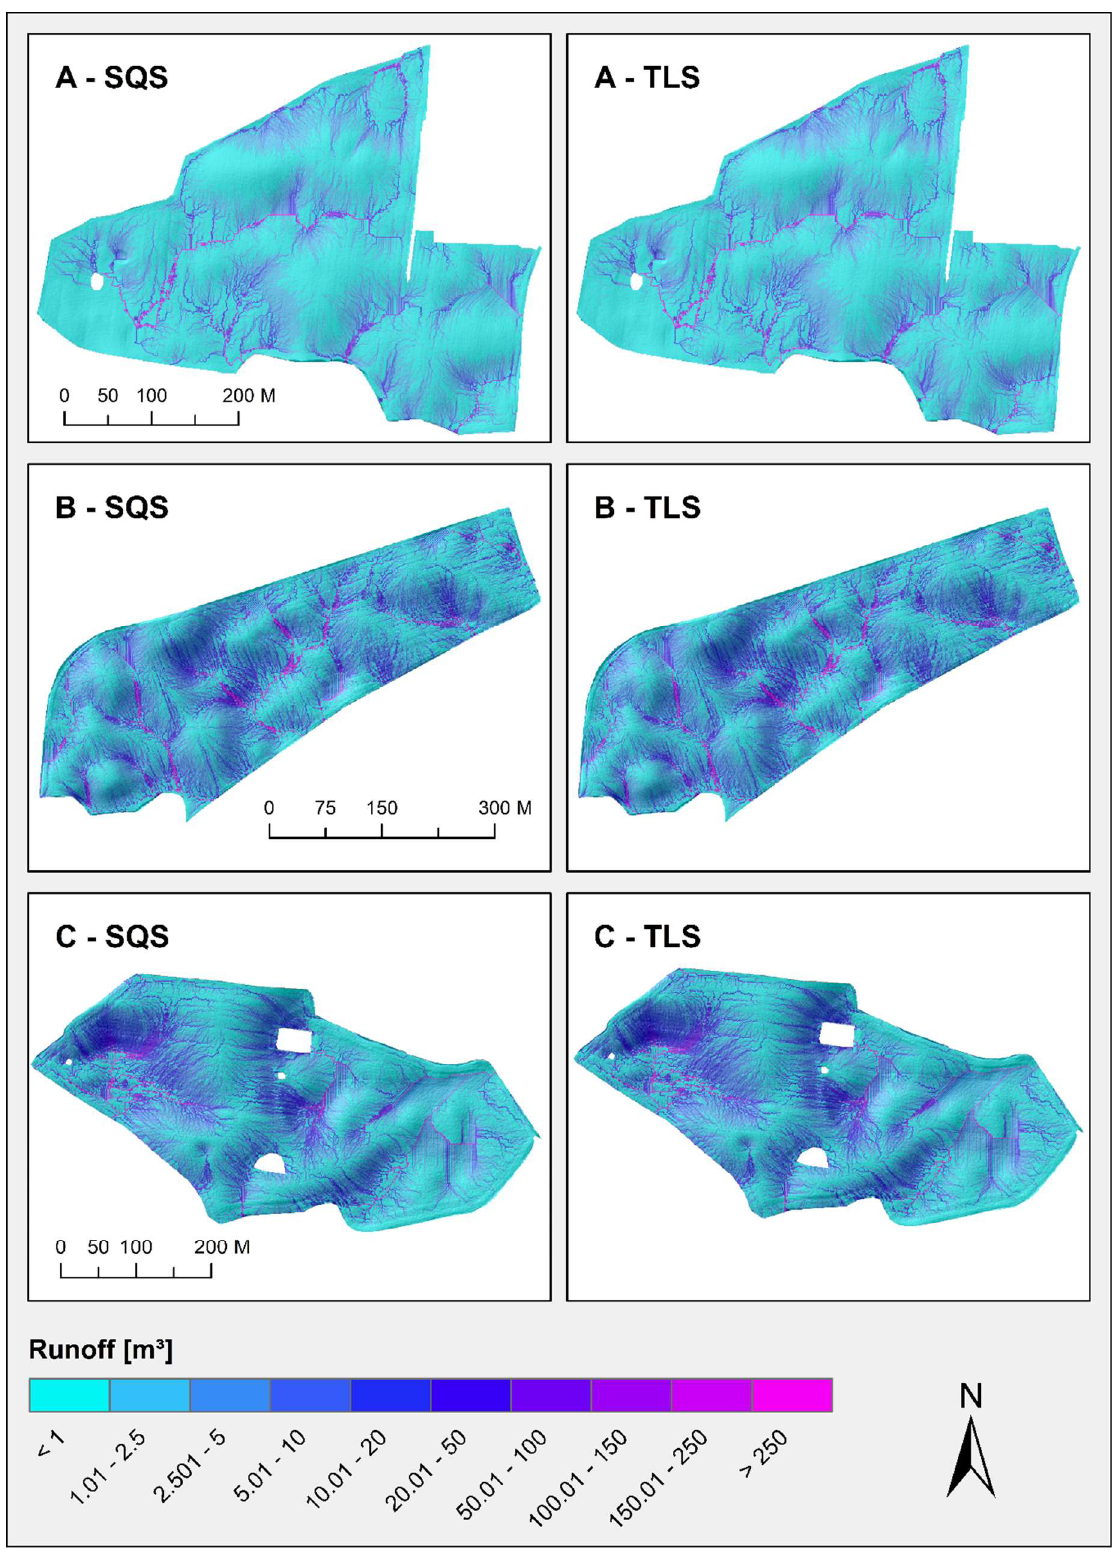
Figure A1. Comparison of simulated runoff for investigated fields (A, B, C) and between SQS (left side) and TLS (right side) for 1 × 1 m grid size.